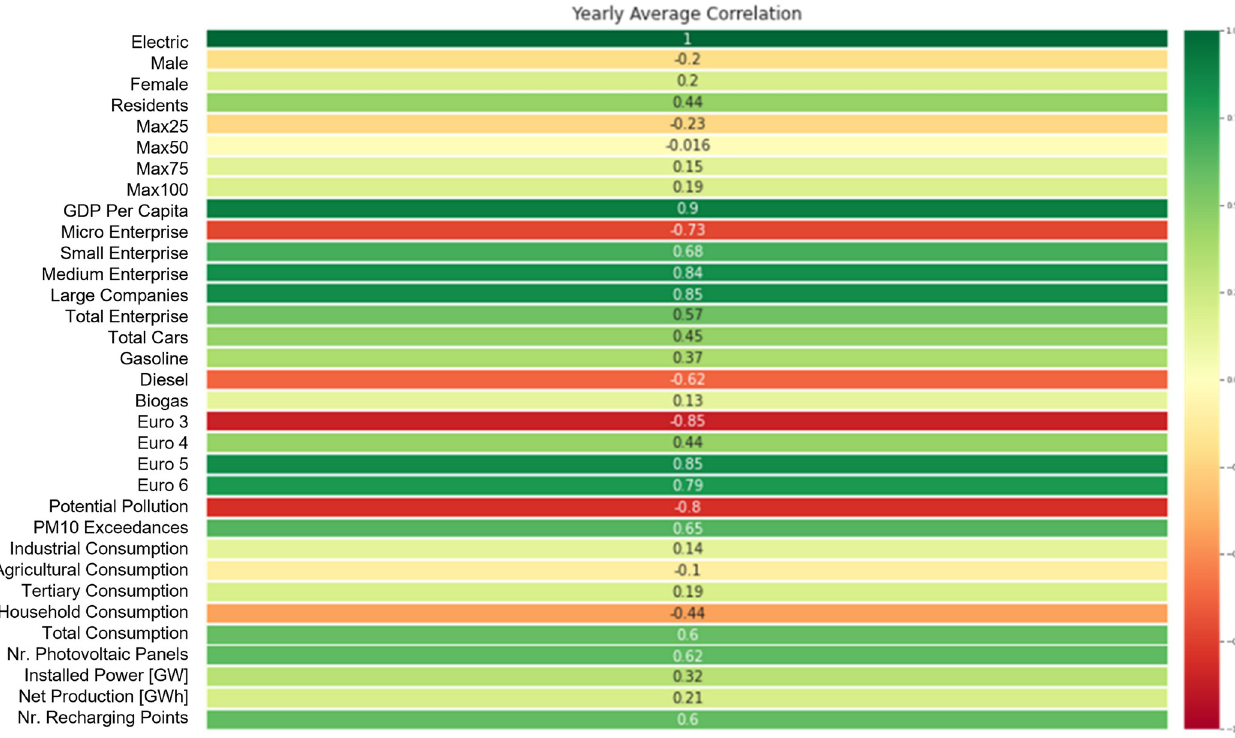
Fig 1. Regional features average Pearson correlation coefficient with the target variable (regional percentage of EVs). The average is computed as the mean value of yearly correlations. Values are included in the range [–1,1].